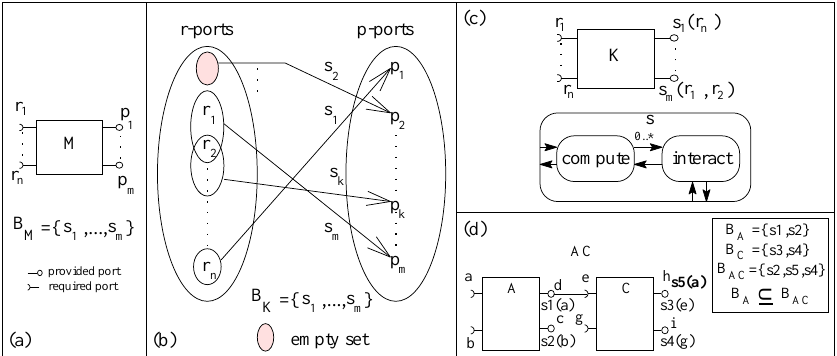
Figure 15. ( a ) A component, ( b ) Port relations, ( c ) Execution semantics, and ( d ) A